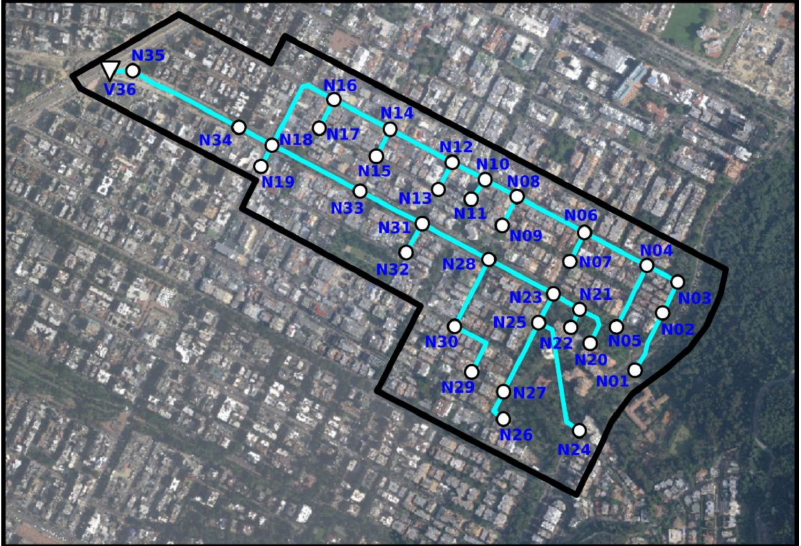
Figure 5. Representation of the E-Chico network in the Storm Water Management Model (SWMM) model. (Background image taken from [31]).